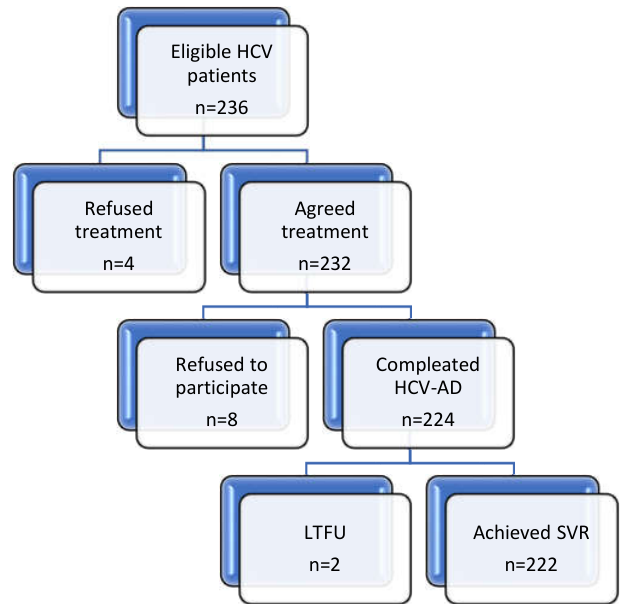
Figure 1. Study design and participant flow. HCV, hepatitis C virus; HCV-AD, the medication adherence questionnaire; LTFU, lost to follow-up; SVR, sustained virologic response.